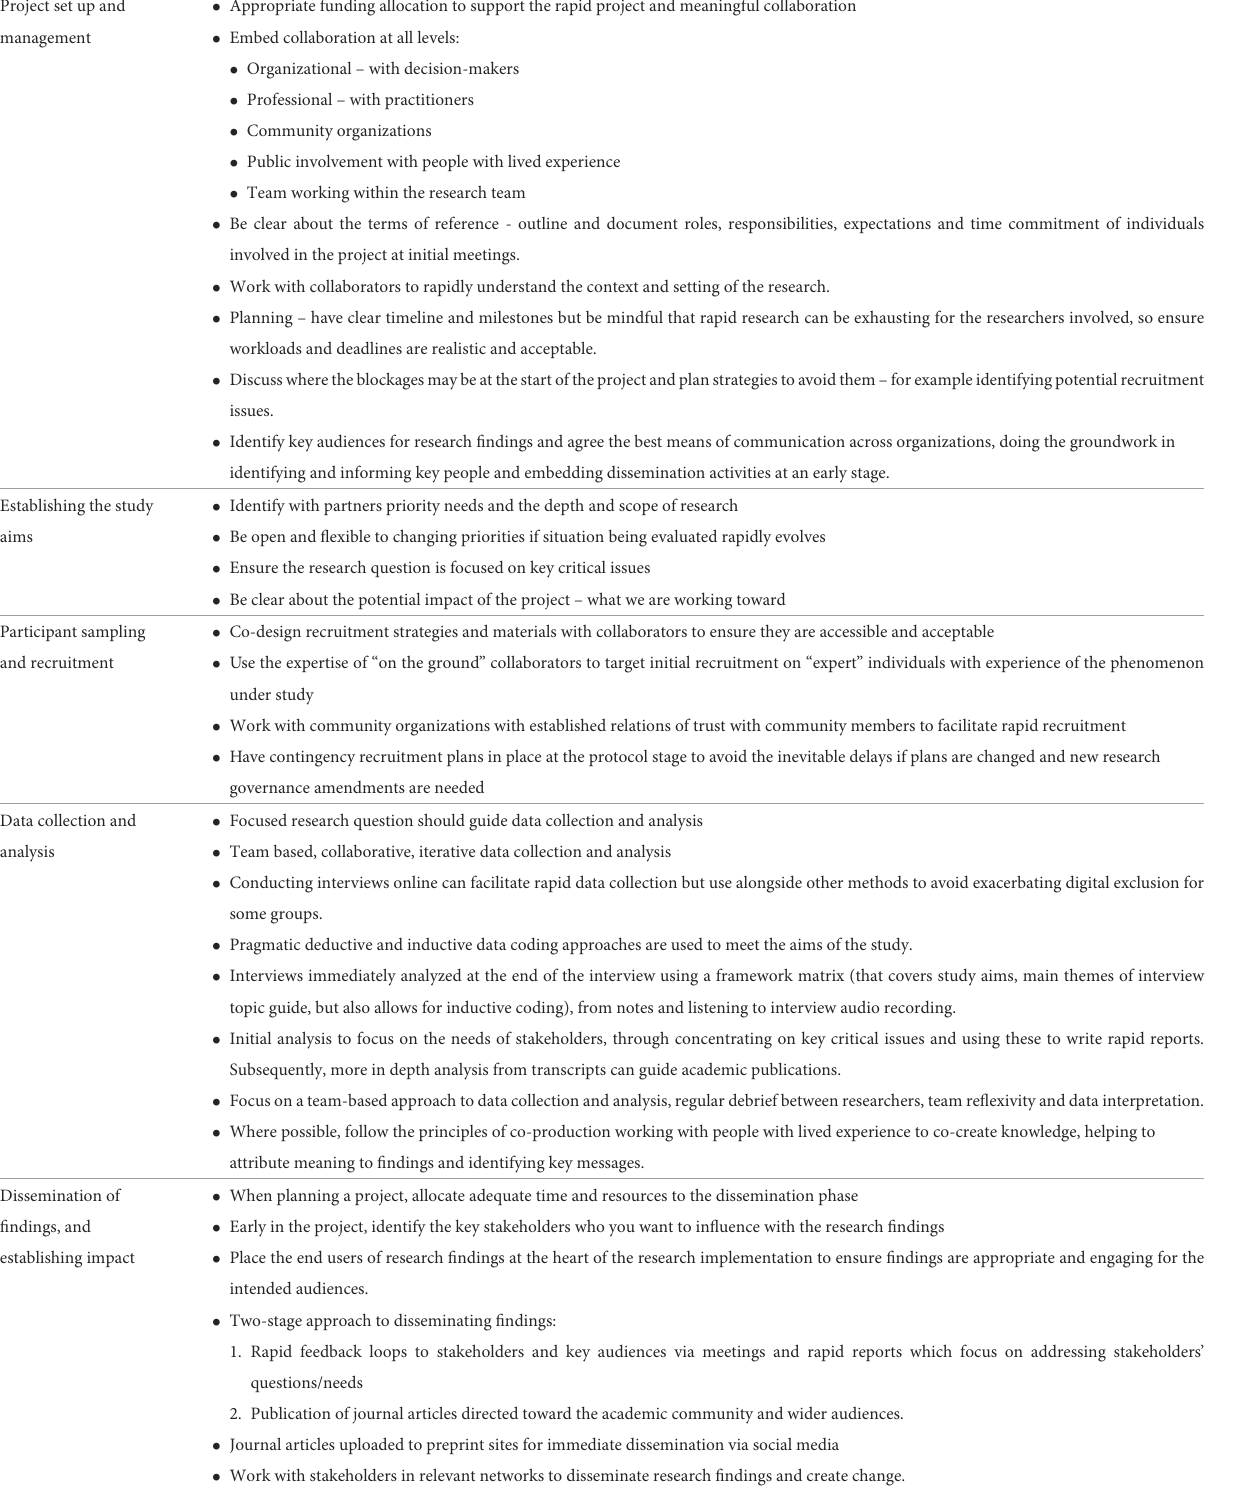
TABLE 1 Summary of CLIP-Q design